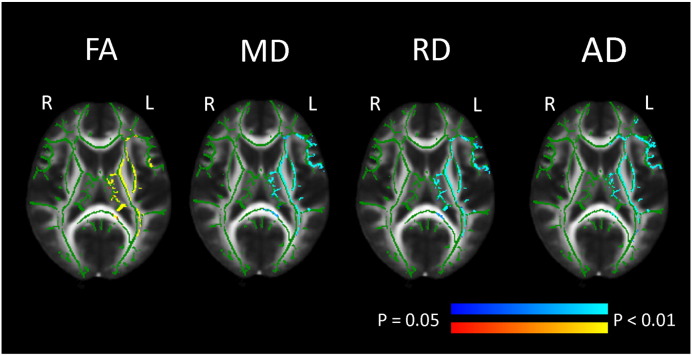
Title: Global hemisphere differences for FA, MD, RD and AD.Global hemisphere differences showing significantly (p < 0.05, correction for multiple comparisons across space) greater positive change (yellow and red) in left hemisphere compared to right hemisphere (L > R) for FA, and greater positive change (blue and light blue) in the right hemisphere compared to left hemisphere (L < R) in MD, RD and AD. Results are overlaid on the FA symmetrized skeleton (green), displayed on the FMRIB FA template in MNI space. L = left hemisphere and R = right hemisphere. Z MNI coordinates = 85.